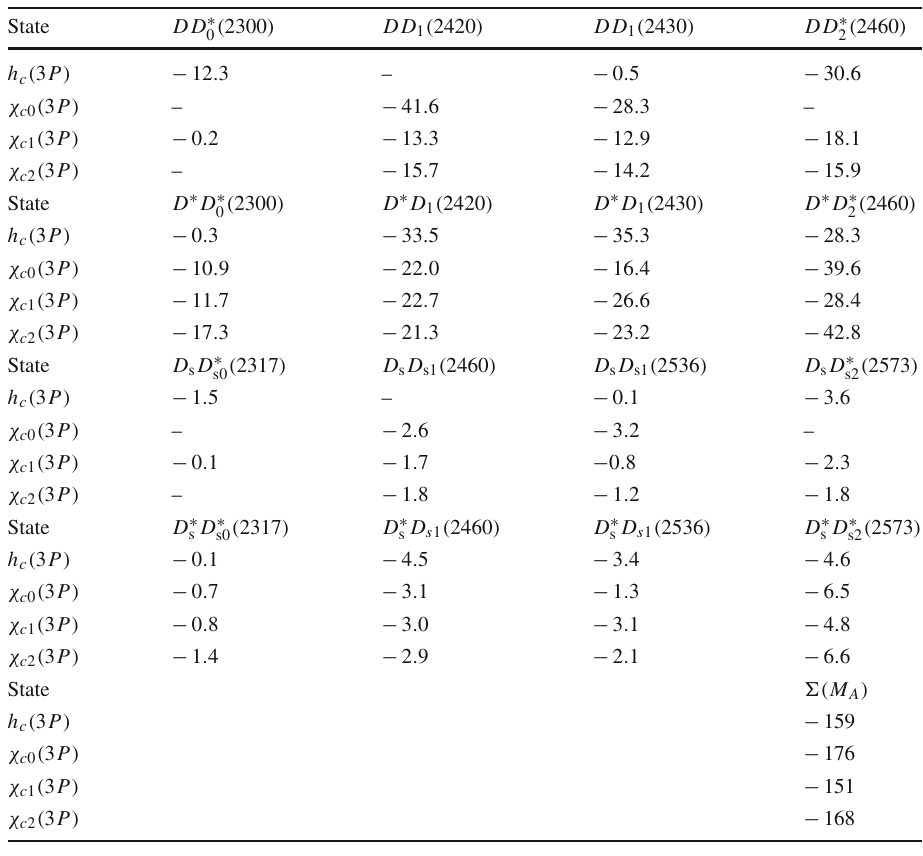
corrections, (cid:12)( M A ) (in MeV), to the bare masses of χ c ( 3 P ) states, calculated via Eq. (5). The values of the UQM parameters are extracted from [46, Table II]. The first rows show the partial contributions to (cid:12)( M ) from channels BC , such A ( 2300 ) , DD ( 2420 ) , as DD ∗ 1 0 and so on. The last rows provide the total results, obtained by summing the previous partial contributions. The contributions of those channels denoted by – are suppressed by selection rules